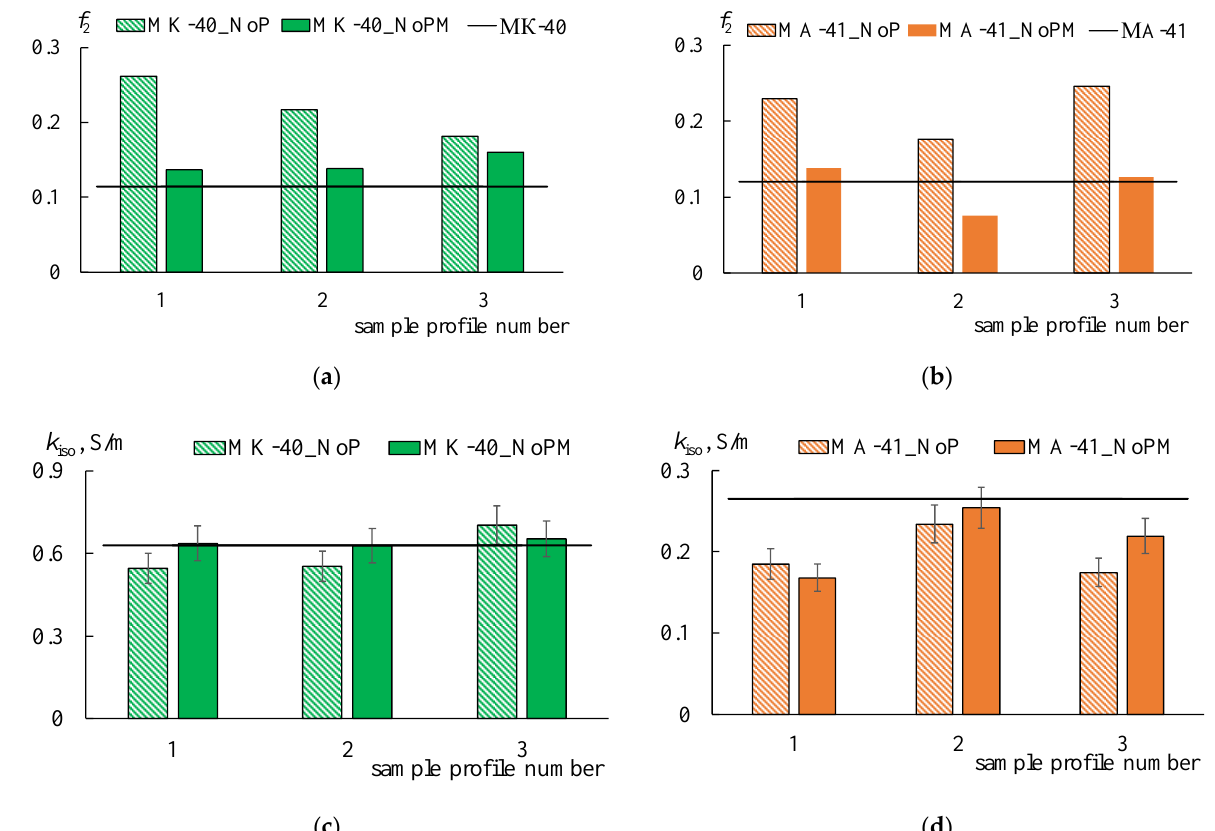
Figure 12. The volume fraction of a gel phase ( f 1 parameter) ( a , b ) and the conductivity of the gel phase ( c , d ) for initial (line), profiled (shaded rectangles), and bilayer profiled membranes (one-colored rectangles). The number on the abscissa axis corresponds to the number of the sample profile in Table 1.